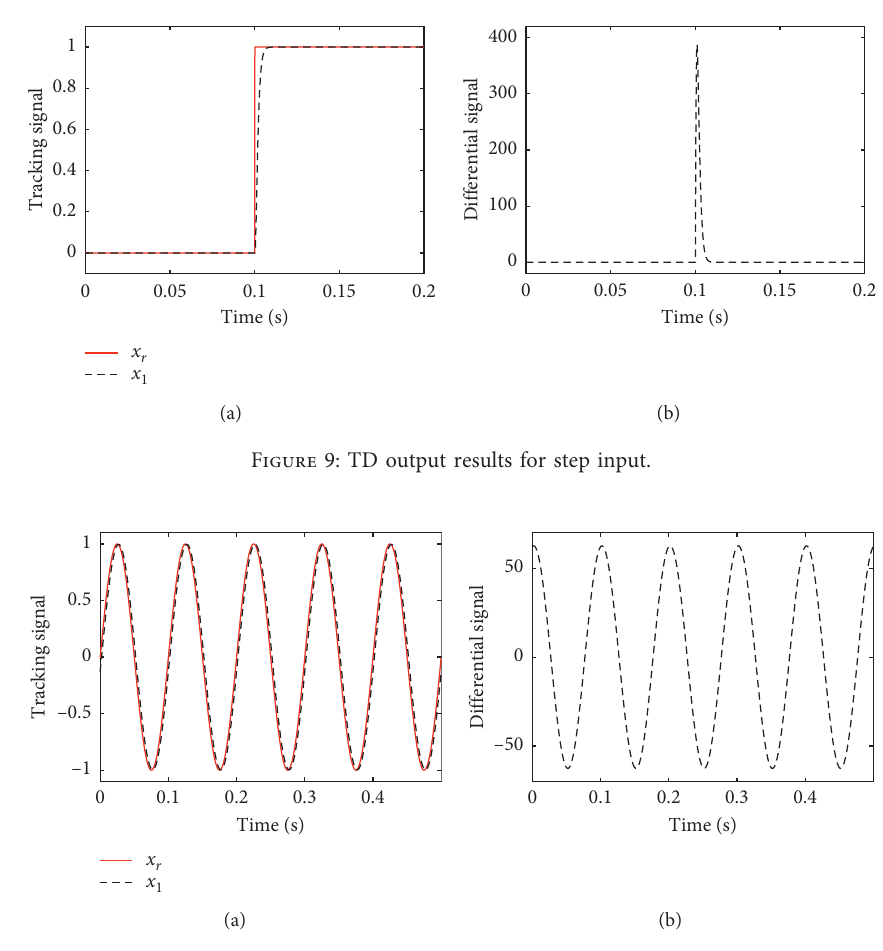
Figure 10: TD output results for sine input